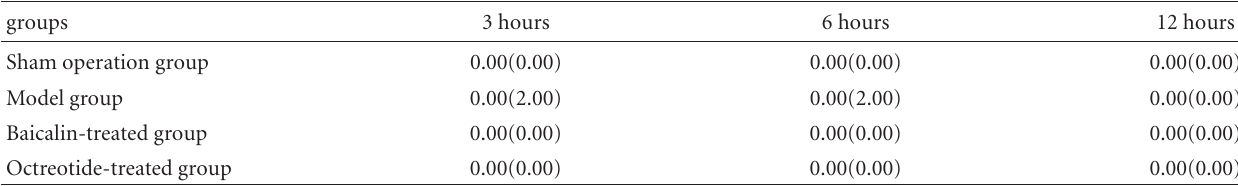
Table 6: Comparison of Bax protein expression in all groups ( M ( Q R